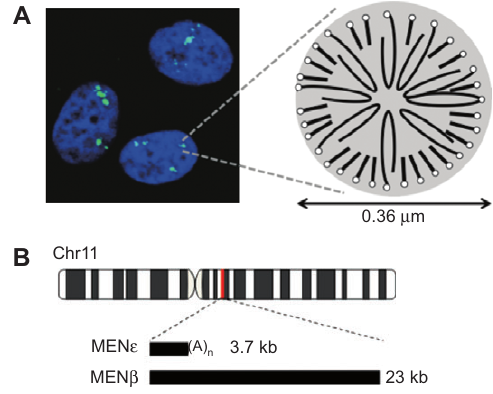
Figure 1 Paraspeckles are built on specifi c long ncRNAs. (A) Paraspeckles detected by RNA-FISH of MEN ε / β ncRNAs (green signal). Nuclei are visualized by staining with DAPI (blue). Right: Cartoon of a paraspeckle, schematically showing the respec- tive locations of MEN ε and MEN β , according to the electron micro- scopic observations by Souquere et al. (43) . The average diameter of a paraspeckle is shown below. The cap structure at the 5 ′ -terminus is represented by a small open circle. (B) Structure of MEN ε / β ncR- NAs. The gene for the MEN ε / β ncRNAs is located at 13q of human chromosome 11. The size of each isoform is shown. MEN ε possesses a canonical poly(A) tail, but MEN β lacks